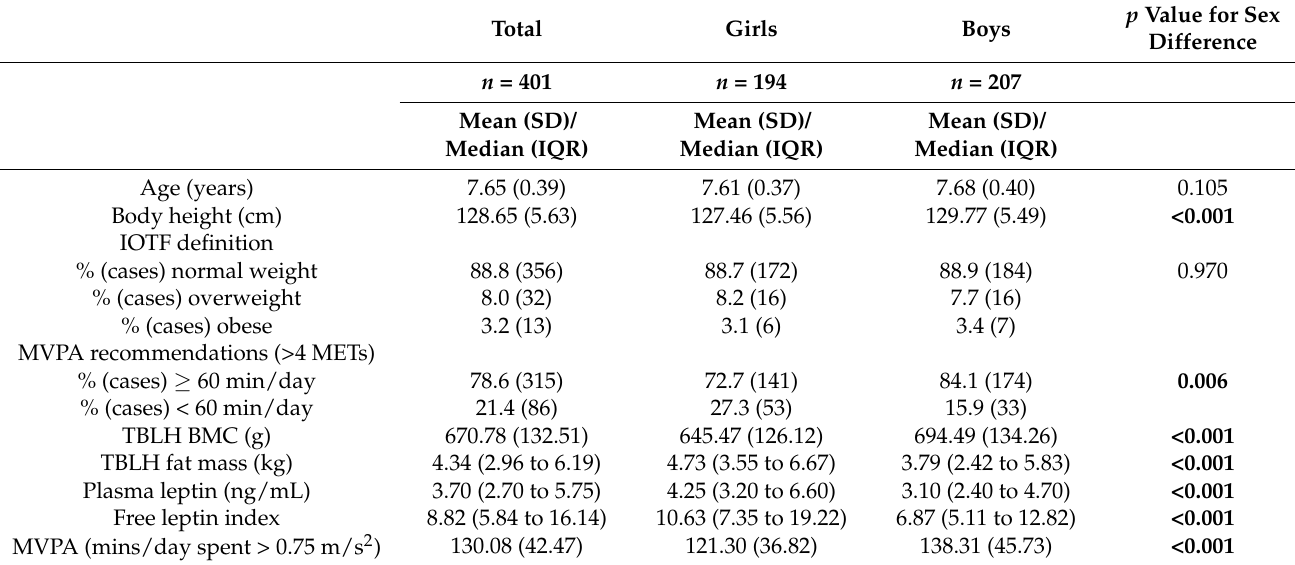
Table 1. Descriptive characteristics of included children.